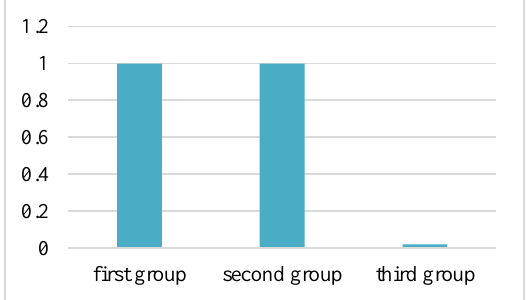
Figure 9. The happiness mode in autistic